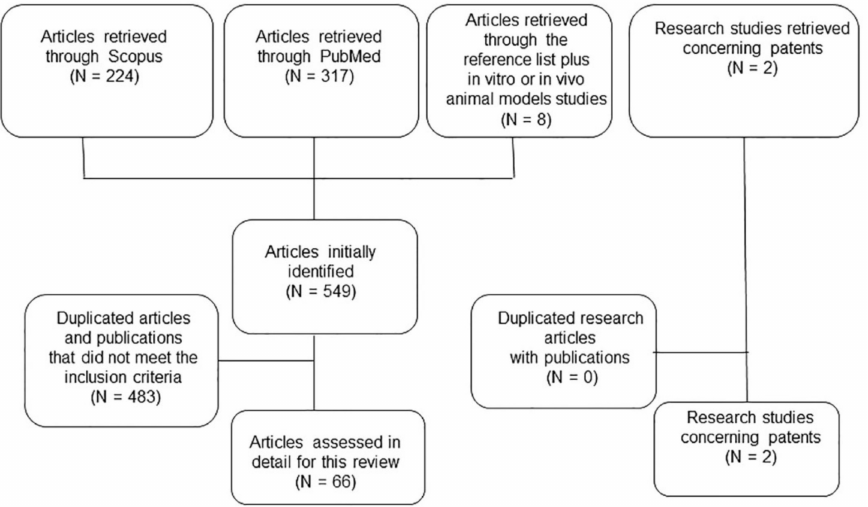
Figure 1. A comprehensive search strategy of scientific articles and clinical studies for this review